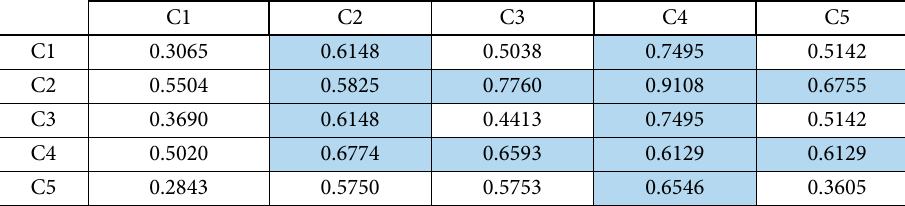
Table 12. Total influence matrix T for inter-cluster